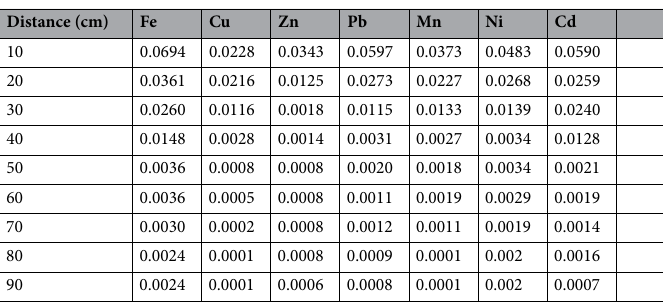
Table 3. Observed concentration of the contaminants in the soils (mol L −1 ).